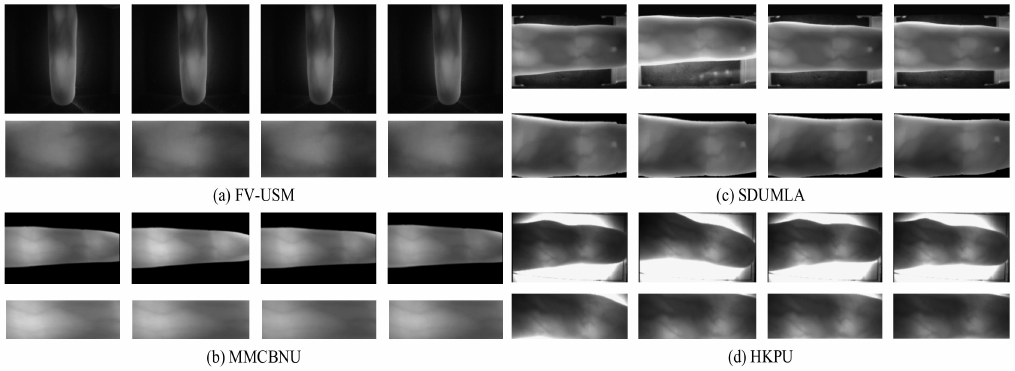
Figure 6. Comparison of finger vein images before and after ROI in four public